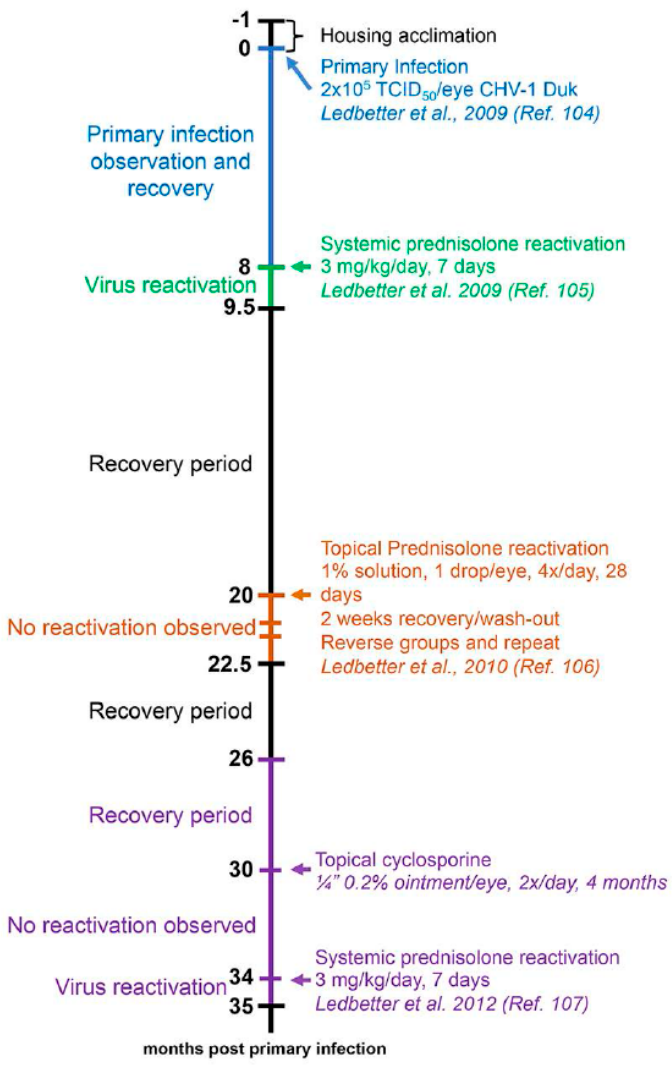
Figure 3. Timeline of the development and validation of the recurrent experimental ocular CHV-1 infection model in dogs. Dogs were initially infected with 2 × 10 5 tissue culture infectious dose 50 (TCID 50 )/eye CHV-1 Duk strain. Virus reactivation was then attempted using different methods in the same colonies of dogs at various times post infection. Different infection or reactivation studies are indicated with different colors.